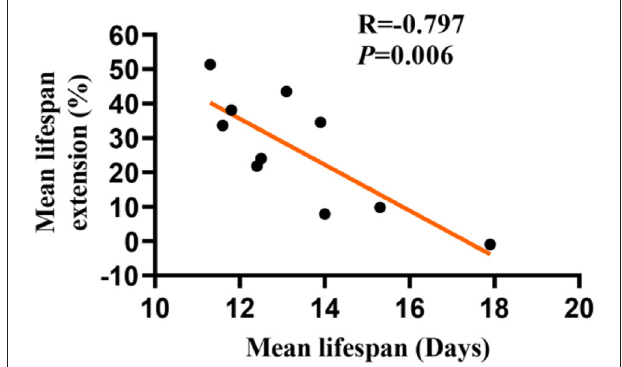
FIGURE 3 | The longevity effects of LBE are negatively correlated with the mean lifespan in C. elegans. Lifespan extension effect of LBE at 5 mg/ml was plotted against the mean lifespan of worms cultured under different conditions. Pearson’s correlation test was used to assess significance (see also Supplementary Table 3 ). LBE, total water extracts of L. barbarum berry.